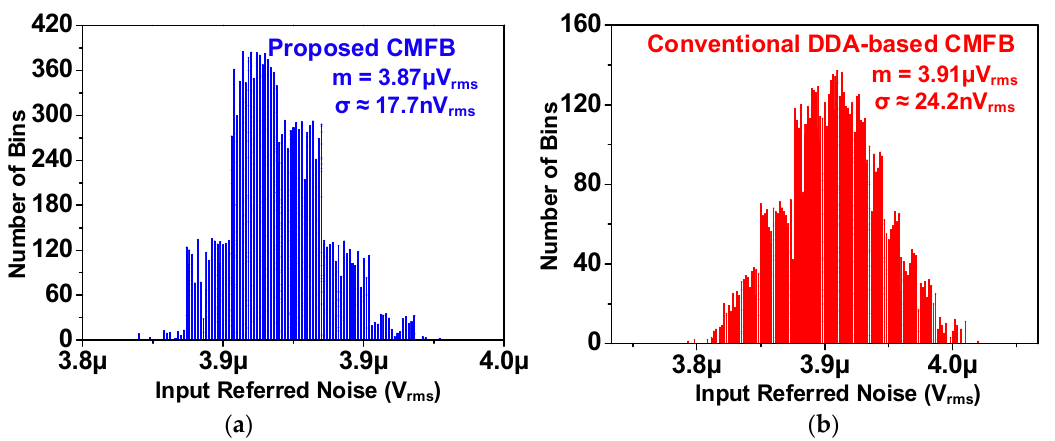
Figure 8. Input referred noise Monte-Carlo simulation for the two neural recording amplifiers. ( a ) Using the proposed CMFB; ( b ) Using the conventional DDA-based CMFB.